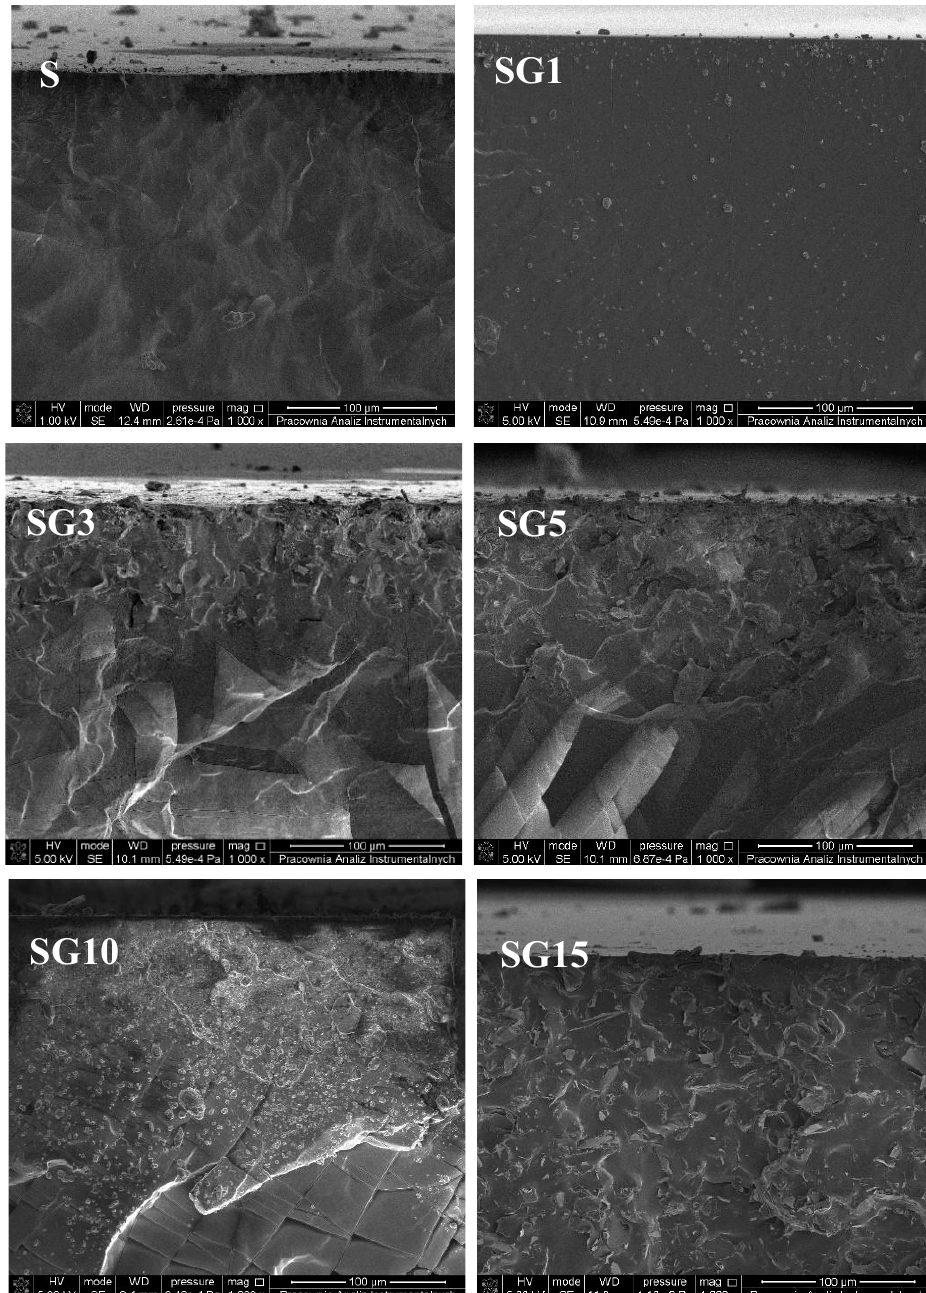
Figure 6. Cross sections of Sylgard and composites containing graphite.